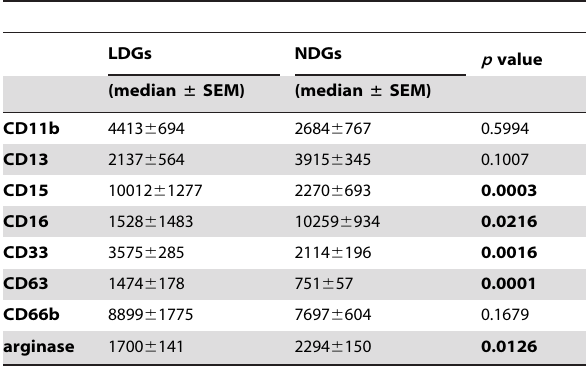
Ldgs And Ndgs Were Isolated From The Blood Of Hiv + Patients With Cd4 + T Cell Counts . 350 Cells/ m L (N=11) As Described In Materials And